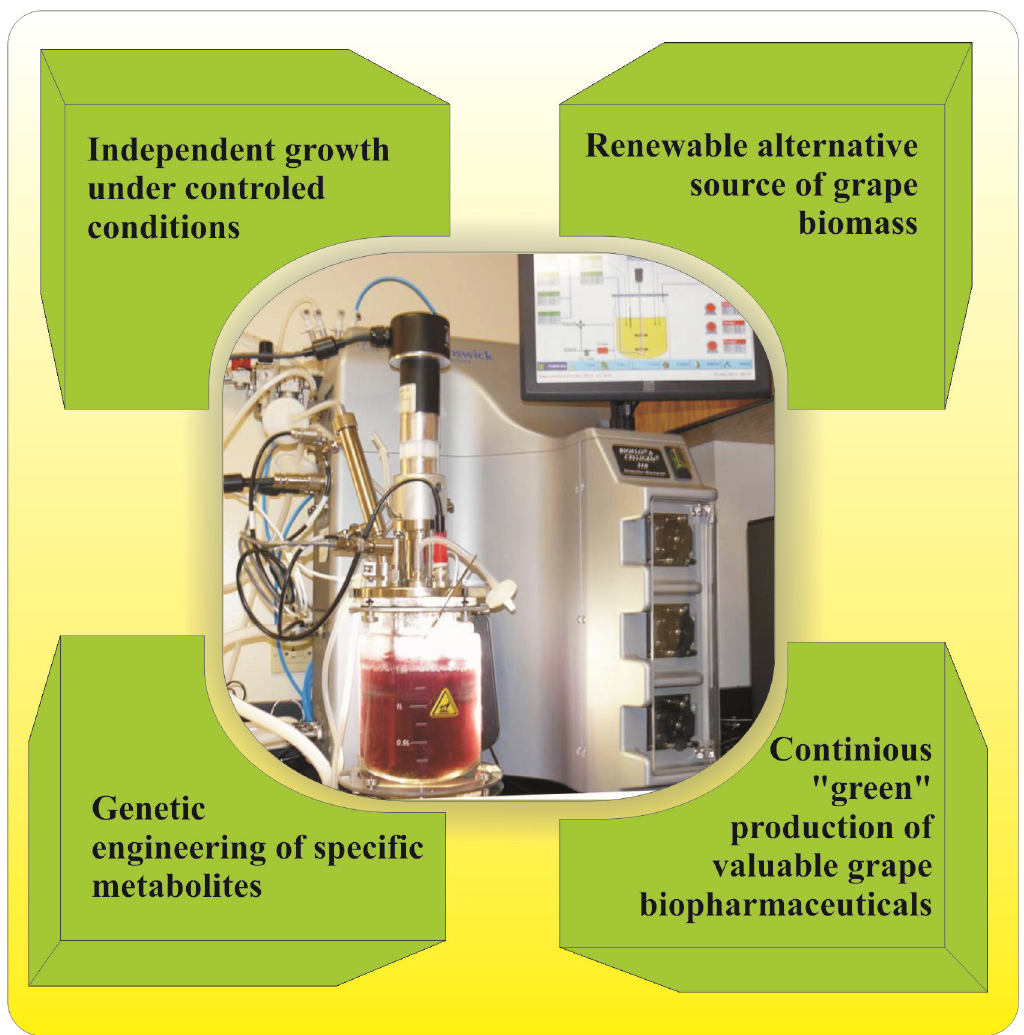
Figure 5. Advantages of in vitro grape cell suspension cultures as a source of